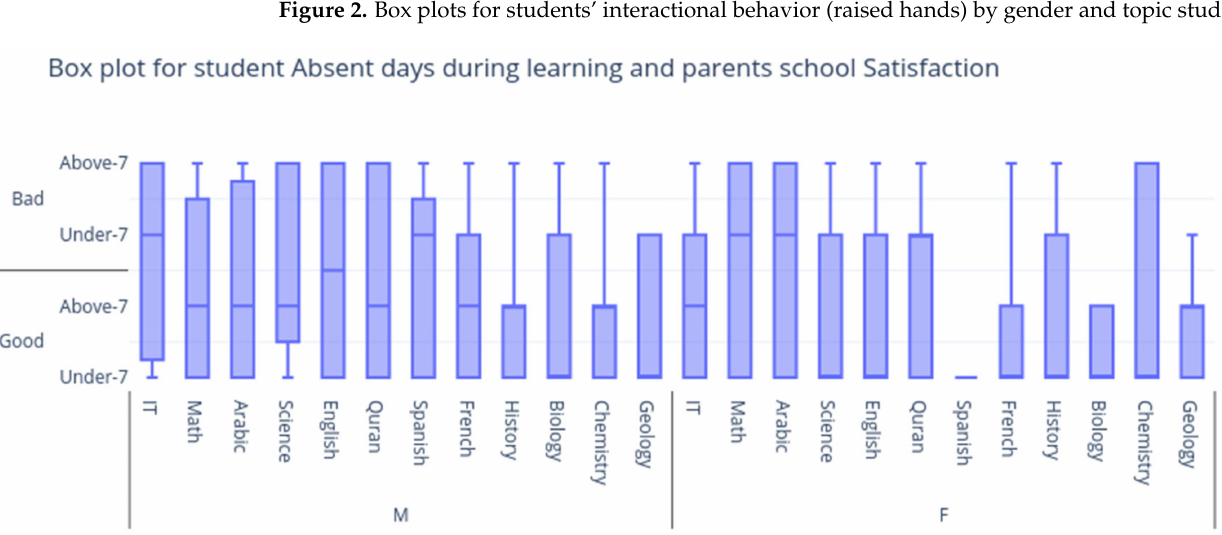
Figure 3. Students’ absence from class based on their gender, the topic studied, and parental